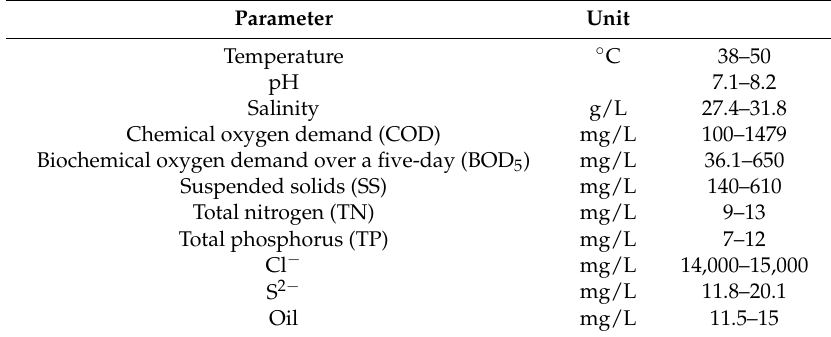
Table 1. Composition of high-salinity wastewater discharged from offshore oil rigs (WORS) (including physico-chemical